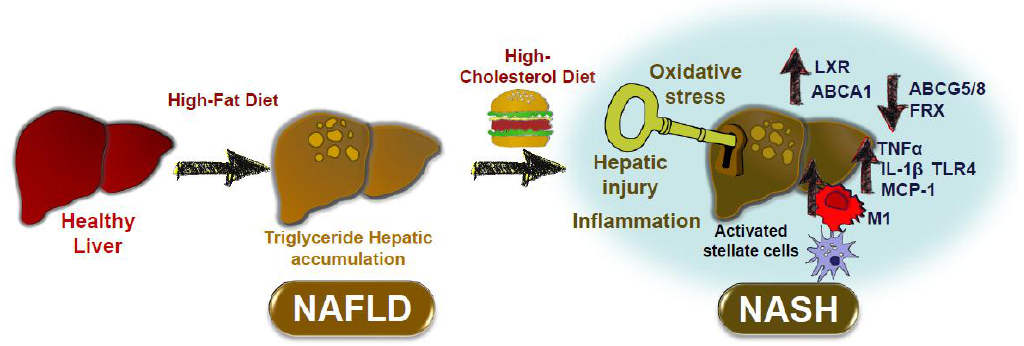
Figure 1. Effect of dietary cholesterol on the progression of NAFLD to NASH. Non-alcoholic fatty liver disease (NAFLD) is characterized by hepatic lipid accumulation. A high-cholesterol diet promotes the progression toward non-alcoholic steatohepatitis (NASH) by several key mechanisms including hepatic stellate cell activation, oxidative stress, activation of inflammatory pathways and hepatocyte death. Dietary cholesterol promotes NASH by modulating the expression of hepatic metabolic genes such as FXR and ABCG5/8 , as well as the expression of cytokines like TNF α , IL-1 β , and MCP1. A change in macrophage phenotype in resident macrophages or Kupffer cells toward a M1 phenotype has been suggested. Other proposed mechanisms include the activation of TLR4-dependent pathways and the upregulation of ABCA1 by LXR nuclear receptors.